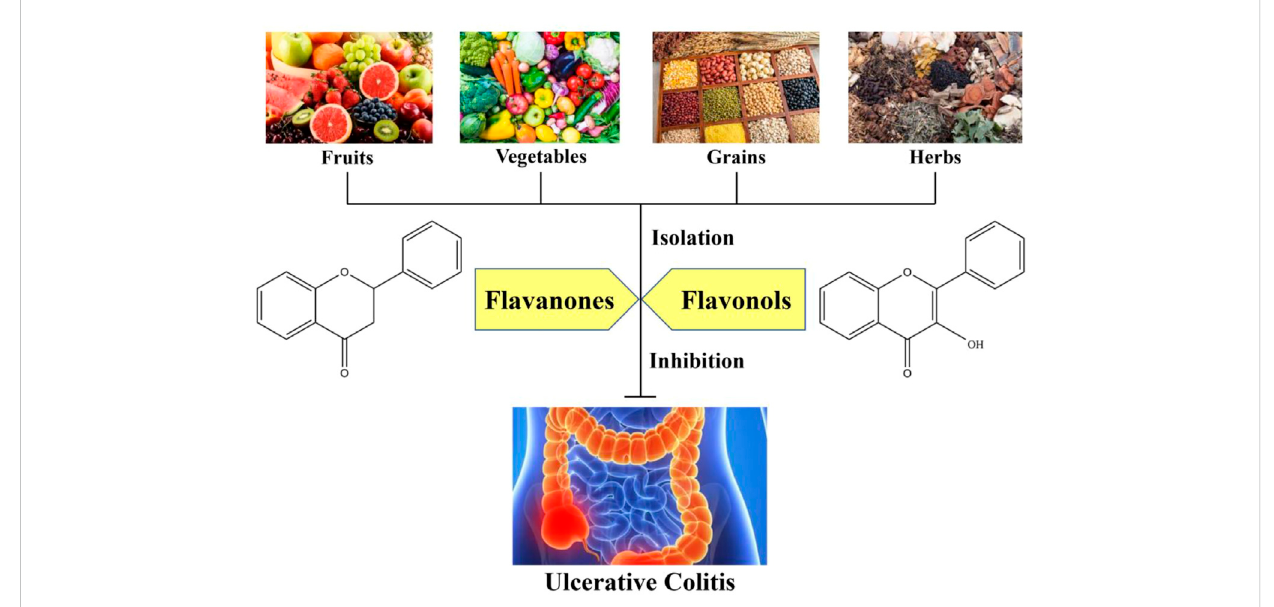
Natural sources of fl avonols and fl avanones against colitis in the past two